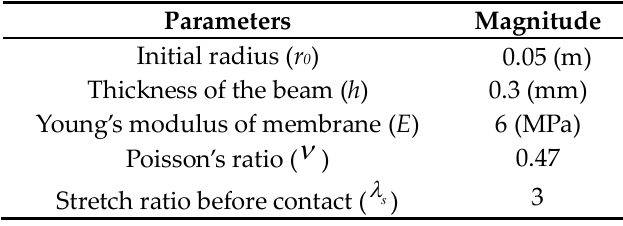
Table 1. Material and geometric parameters.